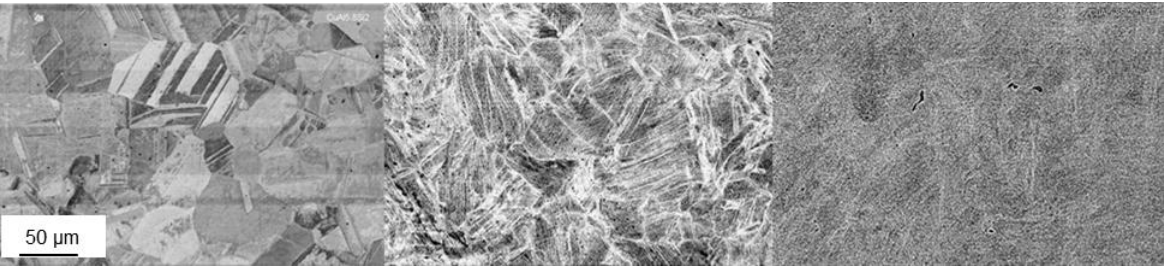
Figure 15. Evolution of an ultrafine-grained structure in single phased low-stacking fault alloy CuAl5.8Si2 by swaging ( Left : non-swaged; Middle : swaged to a logarithmic strain of −0.8; Right : swaged to a logarithmic strain of